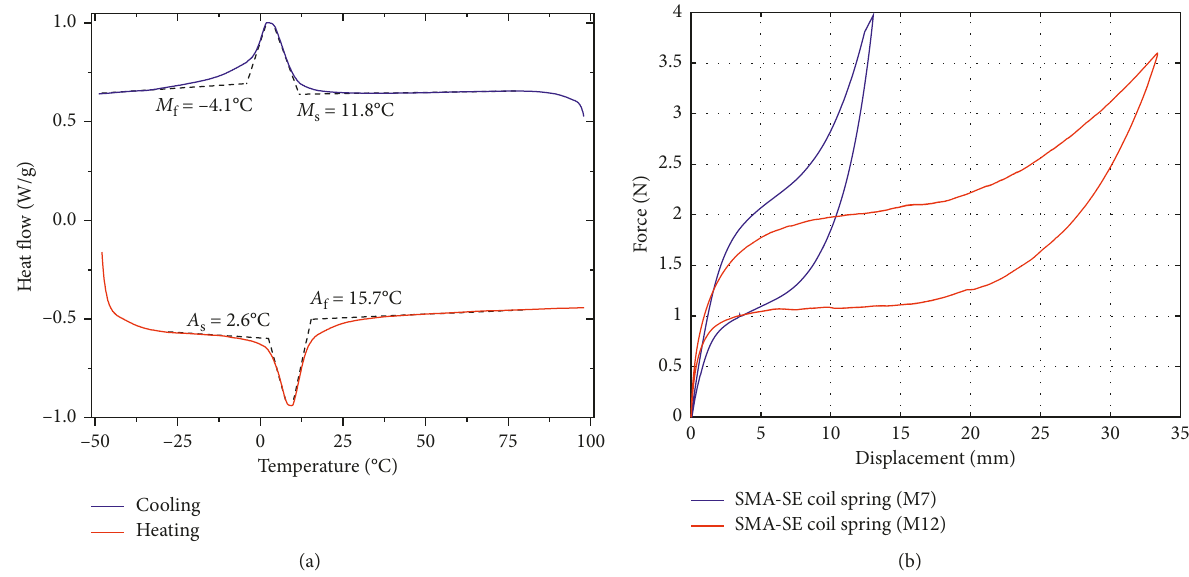
Figure 10: Characterization of SMA-SE absorbers elements. (a) DSC and (b) dynamical test at room temperature and quasistatic